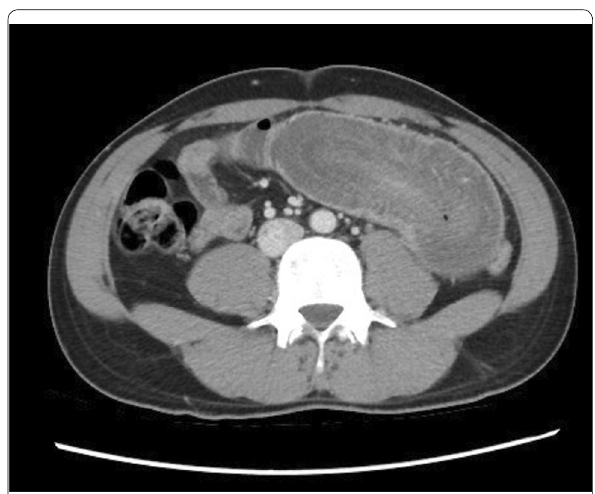
Fig. 3 CT scan abdomen with contrast showed a long segment entero-enteric (jejuno-jejunal) intussusception seen mainly in the left side of the abdomen